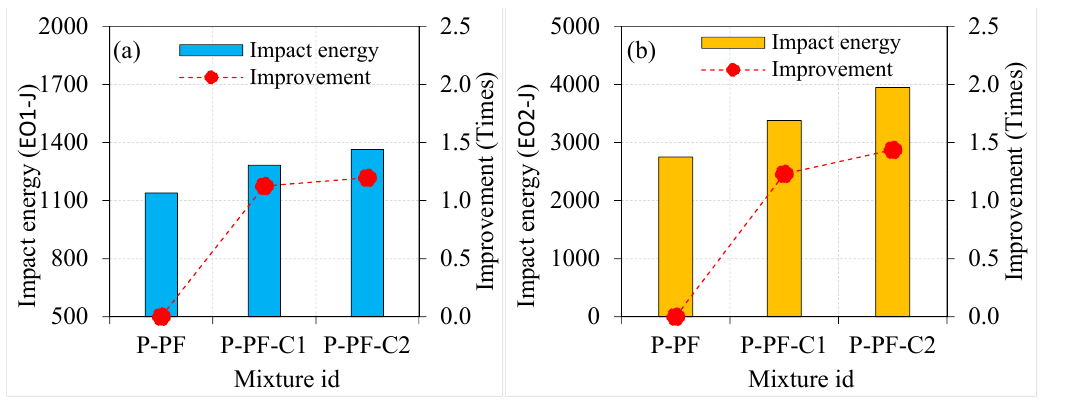
Figure 11. Effect of asphalt coating on impact strength of PF-based specimens ( a ) EO1 and ( b ) EO2.